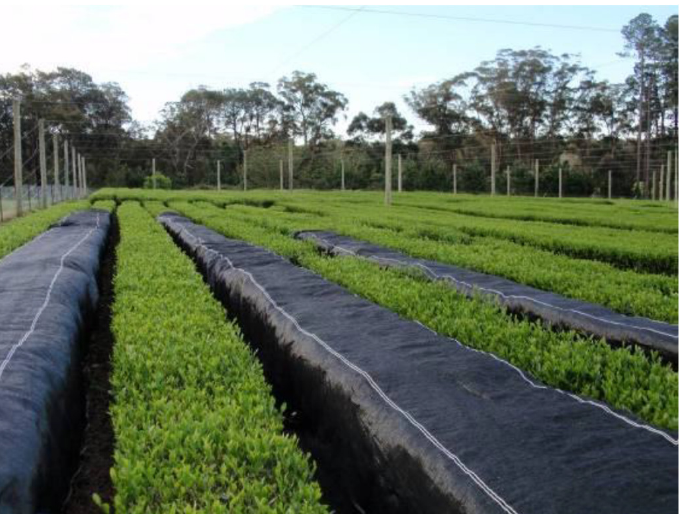
Figure 1. Application of shade cloth to three rows of Camellia sinensis var. sinensis plants, with a single layer of 90% black shade cloth applied to the row covering the top and the side surfaces.